Question: In one sentence, what is this figure communicating?
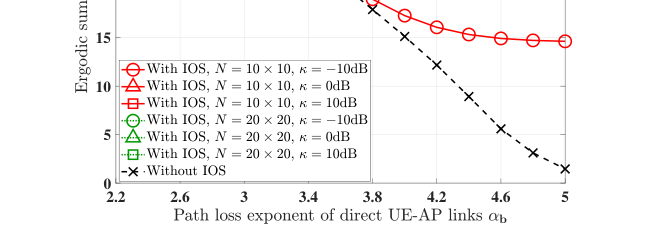
Answer: Simulation comparison of the ergodic sum-rate versus the path loss exponent of direct UE-AP links αb for the IOS-assisted system and the conventional system without IOS, respectively.